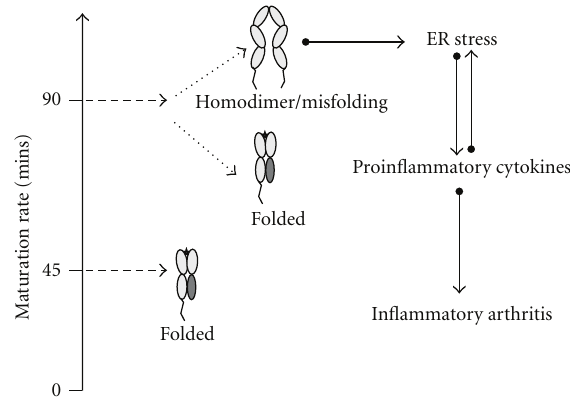
Figure 3: Schematic outline of a hypothetical model of HLA-B27- induced inflammatory arthritis by misfolding and/or dimerisation. HLA-B27 matures slowly resulting in enhanced formation of aggre- gate structures, which can potentially induce ER stress responses and activate proinflammatory cytokine production. ER stress can be perpetuated by further proinflammatory cytokine production, and this can lead to the development of inflammatory